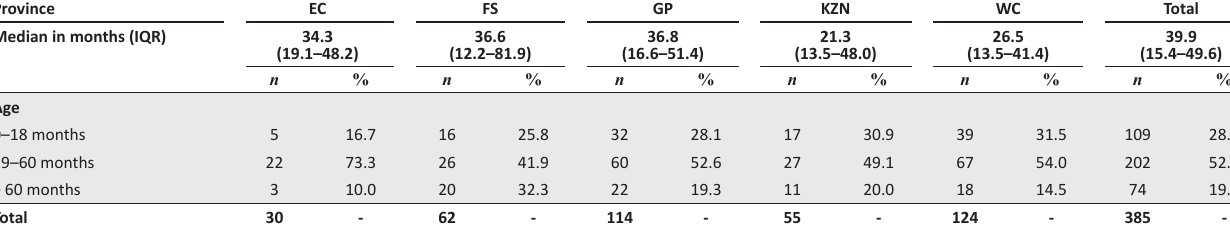
> 60 months 30 EC, Eastern Cape; FS, Free State; GP, Gauteng; KZN, KwaZulu-Natal; WC, Western Cape. TABLE 2: Neuroblastoma age groups at diagnosis from 2000 to 2014 in South Africa. Province EC FS GP KZN Total City EL BLN JHB PTA SWT Age